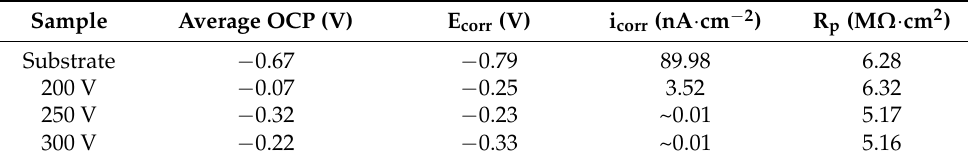
Figure 7. Electrochemical results obtained in 0.9% NaCl solution: OCP ( a ) and PD ( b ) curves. Table 3. OCP average values and electrochemical Tafel’s parameters (±0.01).